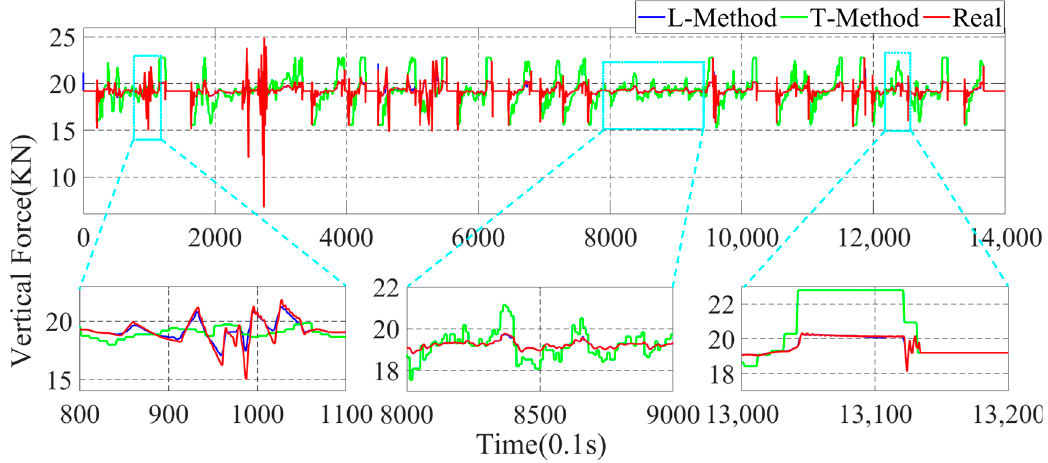
Figure 12. Parameter estimation of the vertical force of the right-front wheel of the vehicle.